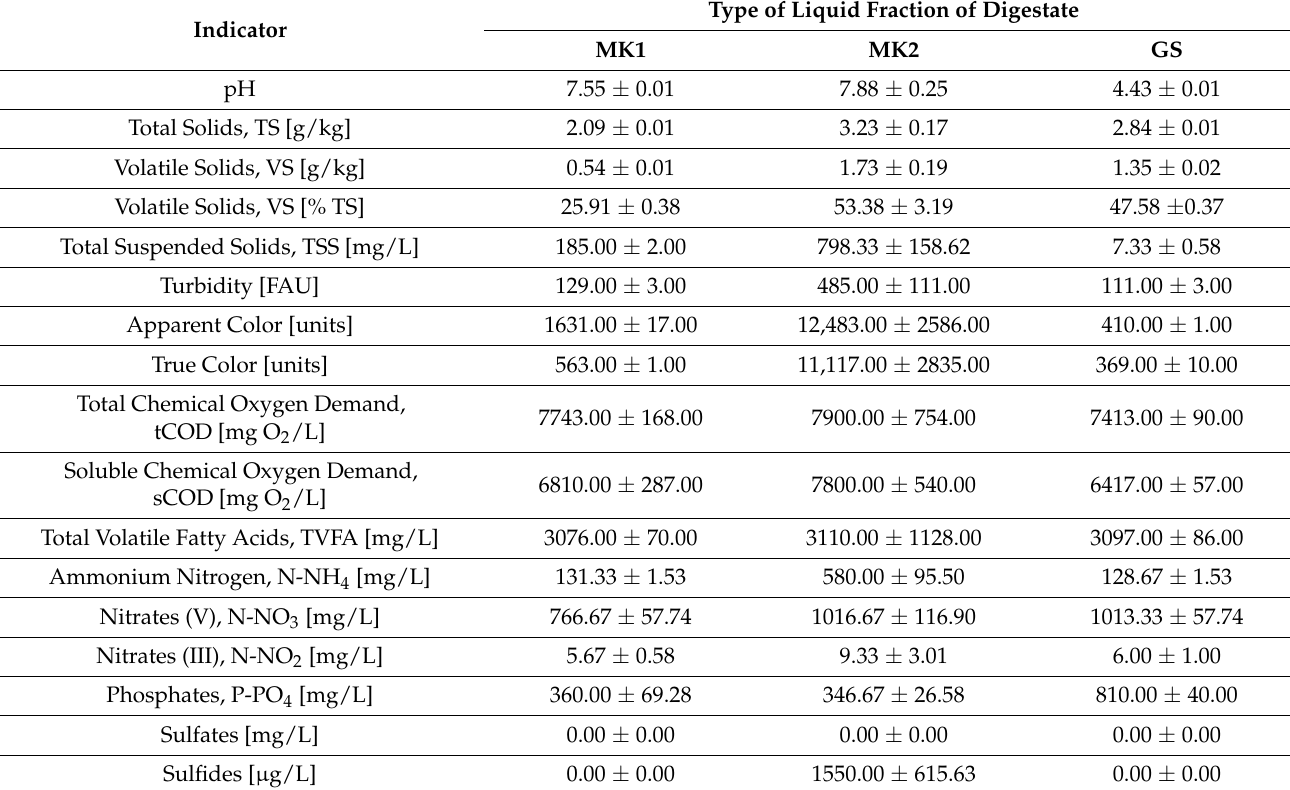
Table 1. Physical and chemical characteristics of the liquid